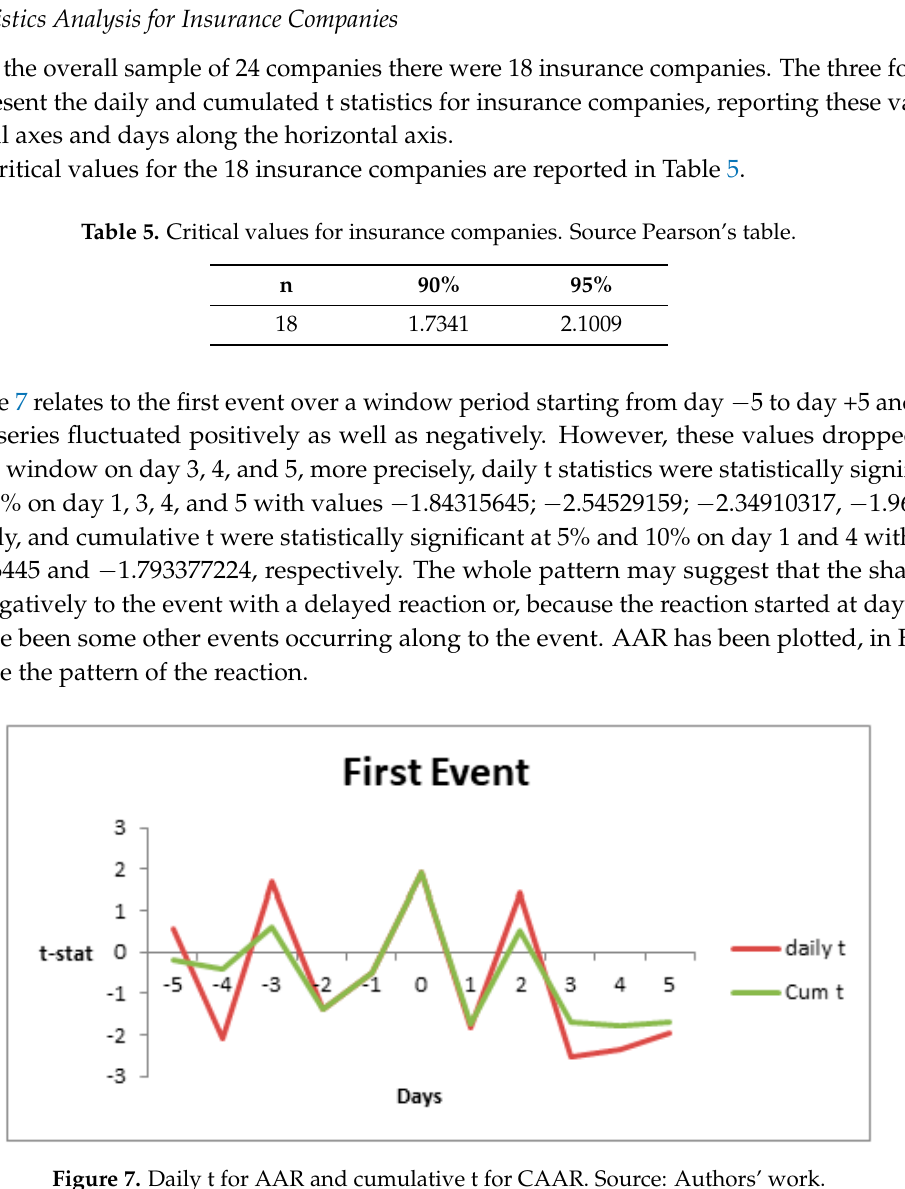
Figure 8. Daily t for AAR and cumulative t for CAAR. Source: Authors’ work.